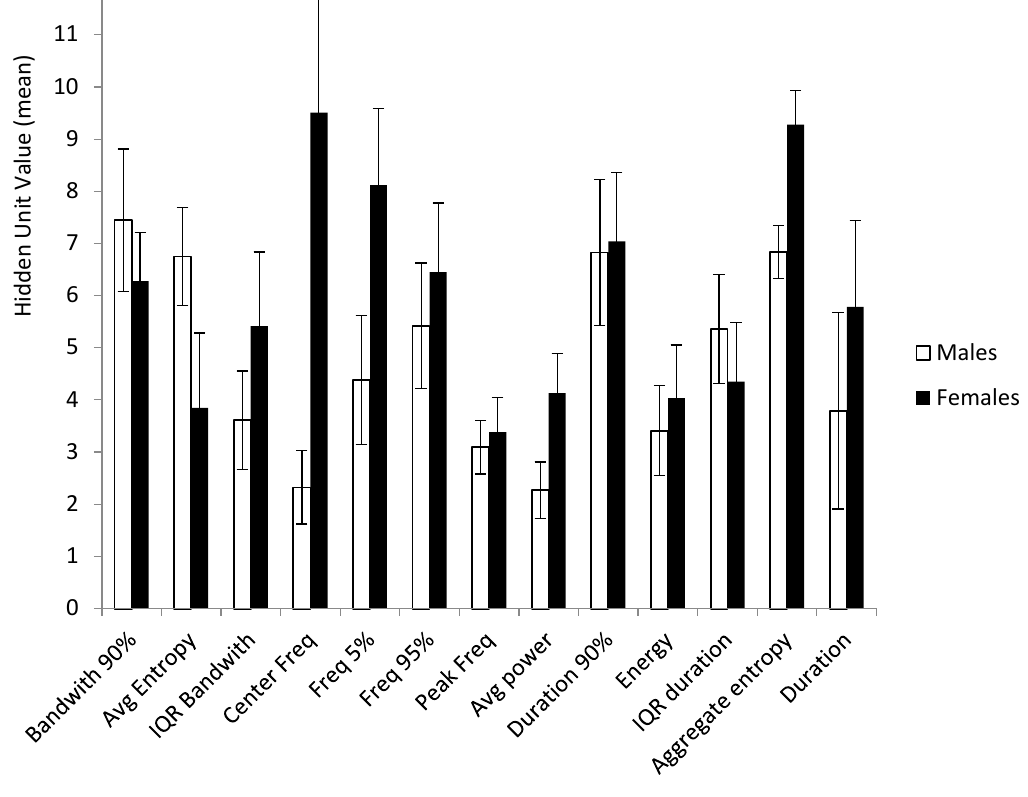
Figure 4. Mean hidden unit values calculated from the five highest performing sex classification networks. Means were calculated using the three hidden units that contributed the most to the success of each neural network. Higher hidden unit values indicate a larger impact on which output unit became active. Bars indicate standard errors of the